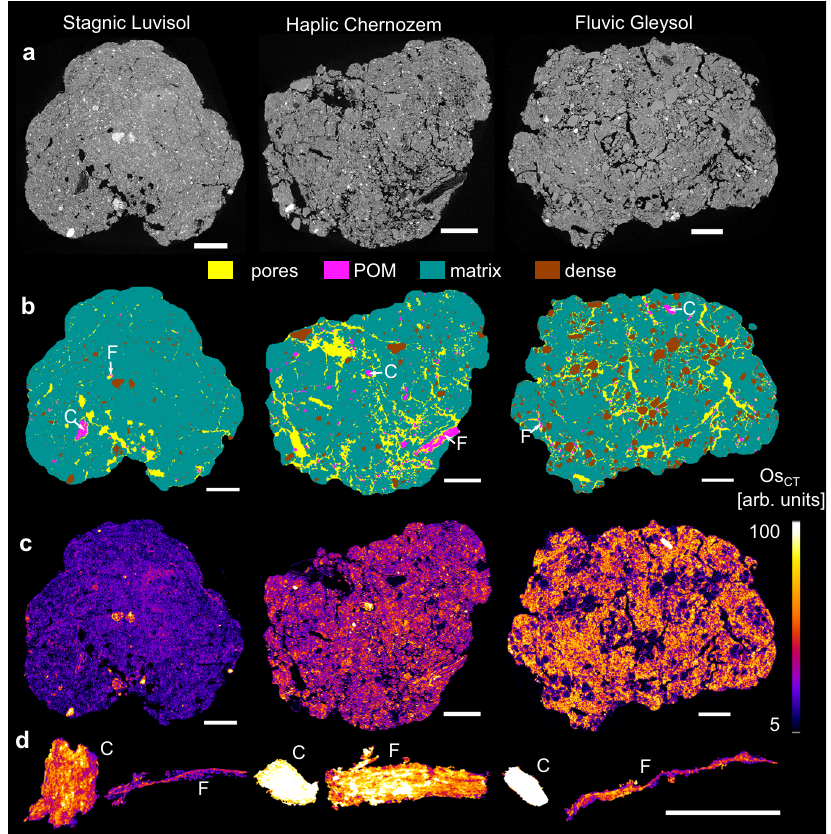
Fig. 1 Microscale characterization of soil structure. a Two-dimensional slices of X-ray tomograms for selected soil aggregates of the Stagnic Luvisol, Haplic Chernozem, and Fluvic Gleysol prior to Os staining. b Segmented images showing the spatial distribution of pores, POM, soil matrix, and dense areas, including rock fragments and Fe-rich nodules. Particulate organic matter is segmented into compact POM (C) and fi brous POM (F) for which one example is shown for each soil. c Difference images of the same slices displaying organic matter stained by Os. The Os concentration (Os CT ) is normalized by reference materials and has arbitrary units. d The average Os concentration in each C and F example is shown as 2D maximum intensity projection through the 3D object. Scale bar represents 1